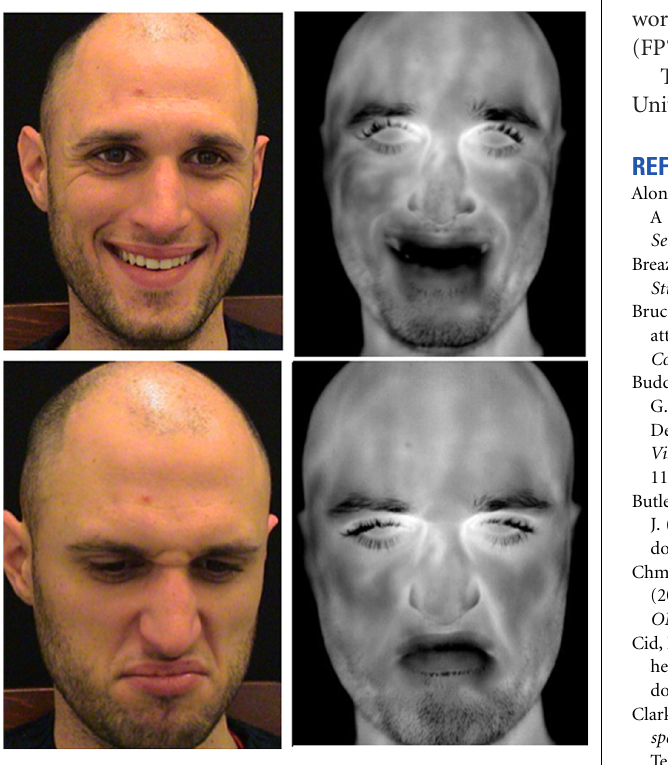
FIGURE 2 |Visible and thermal facial imprints of happiness (upper panel) and disgust (lower panel). Thermal infrared (IR) imaging provides physiological response in addition to the behavioral ones measured through facial expression. Changes into the temperature distribution associated with the two different conditions could help in classifying affective